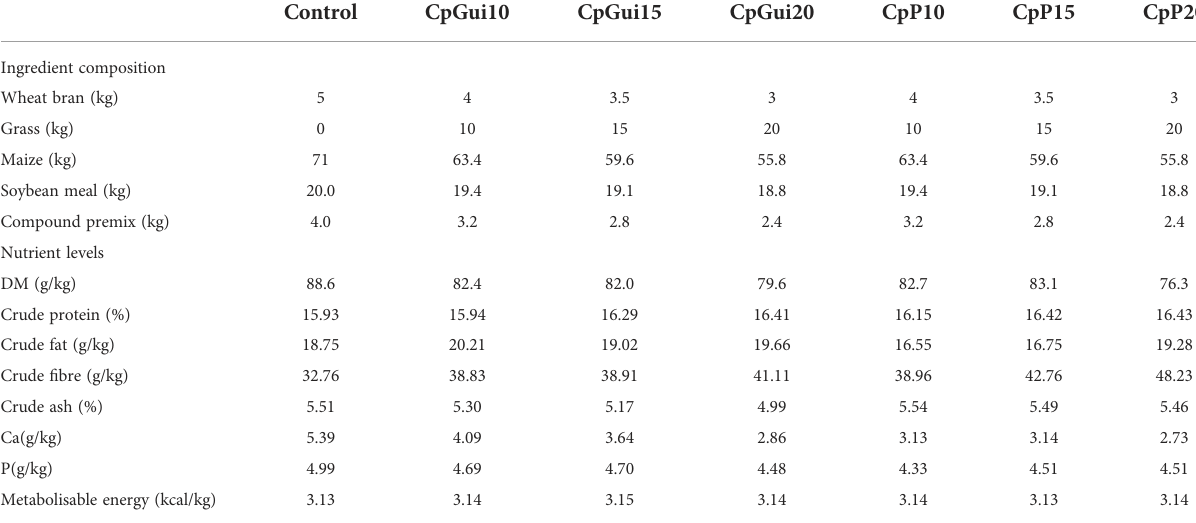
TABLE 1 Composition and nutrient levels of the experimental